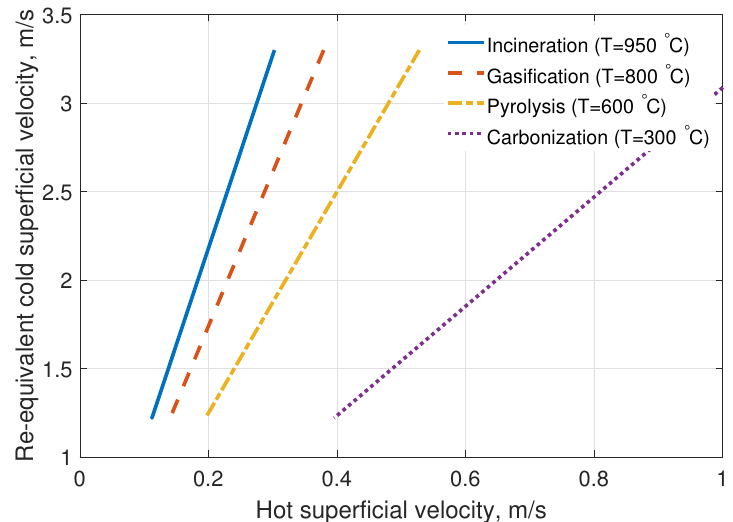
Figure 8. Superficial velocity correction related to the operating